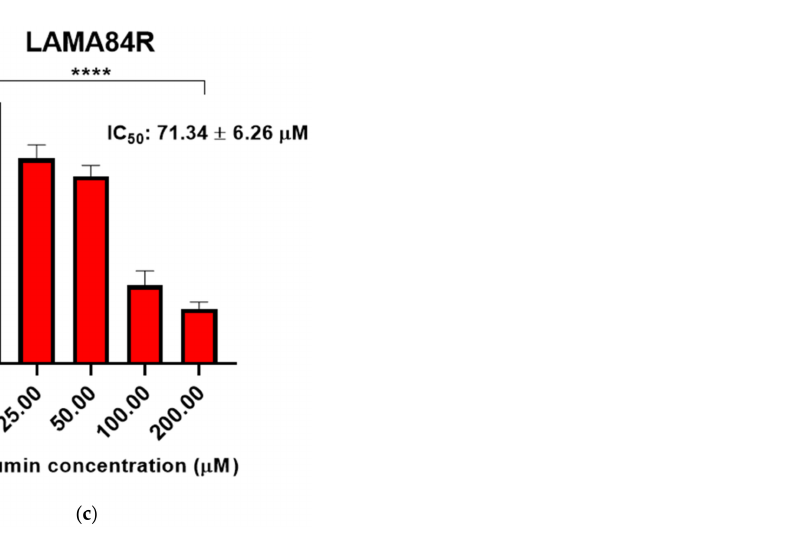
Figure 2. Dose-dependent effects of curcumin on cell viability of ( a ) K562, ( b ) LAMA84S, and ( c ) LAMA84R cell lines measured by WST-8 assay after 48 h treatment. The mean ± standard deviations are shown. The results were obtained from the three independent experiments. * p < 0.05, **** p < 0.0001.